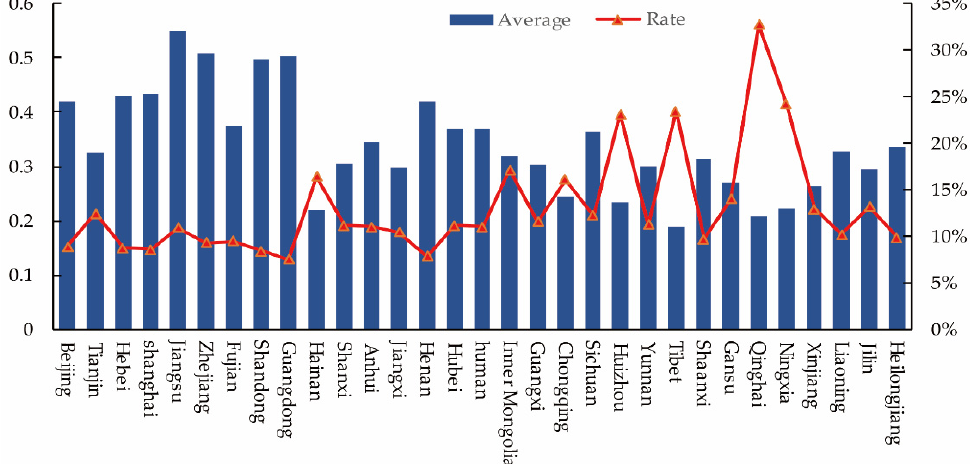
Figure 2. Average DVI and growth rates of 31 provinces from 2005 to 2018 .